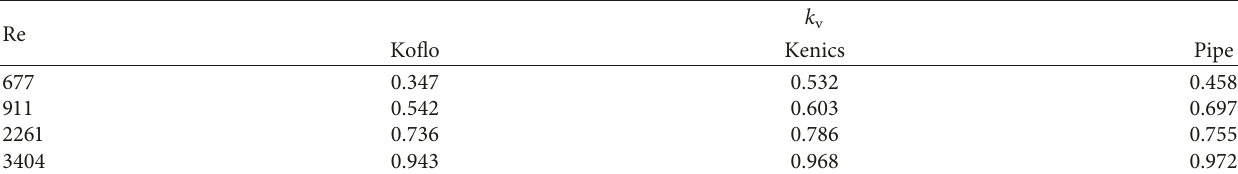
Figure 19: CaF 2 particles after precipitation in the pipe: (a) Re Table 7: The volumetric shape coefficients for the obtained crystals.